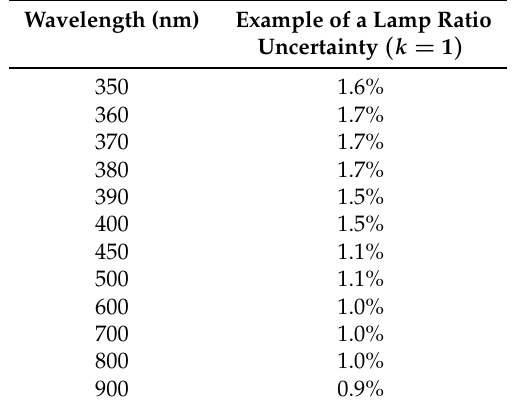
Table 3. Example of an FEL comparison uncertainty